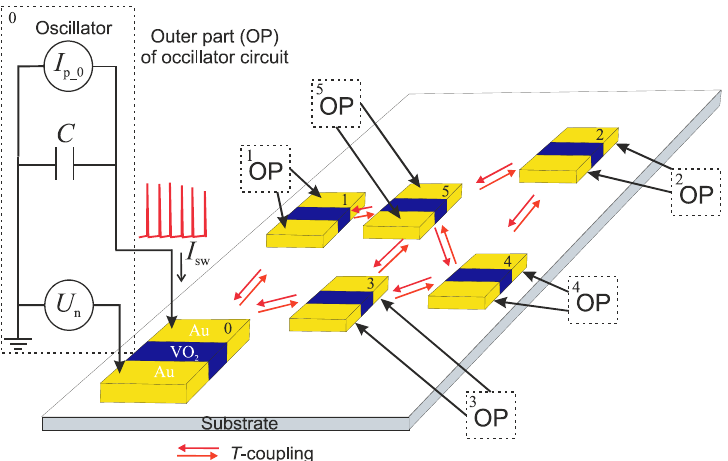
Figure 12. Electrical circuit of thermally coupled VO 2 -oscillators located on the substrate. The numbers of the VO 2 structures correspond to the numbers of the oscillators. Double arrows indicate a thermal bond.